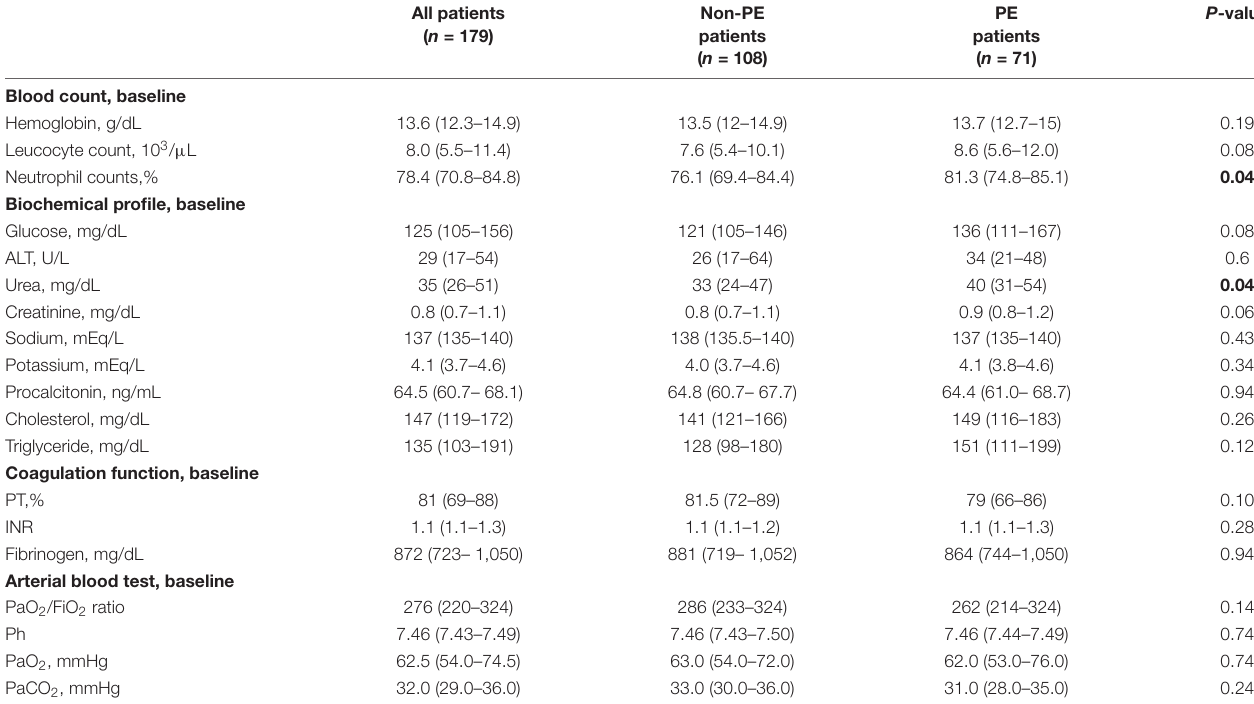
TABLE 2 | Baseline laboratory